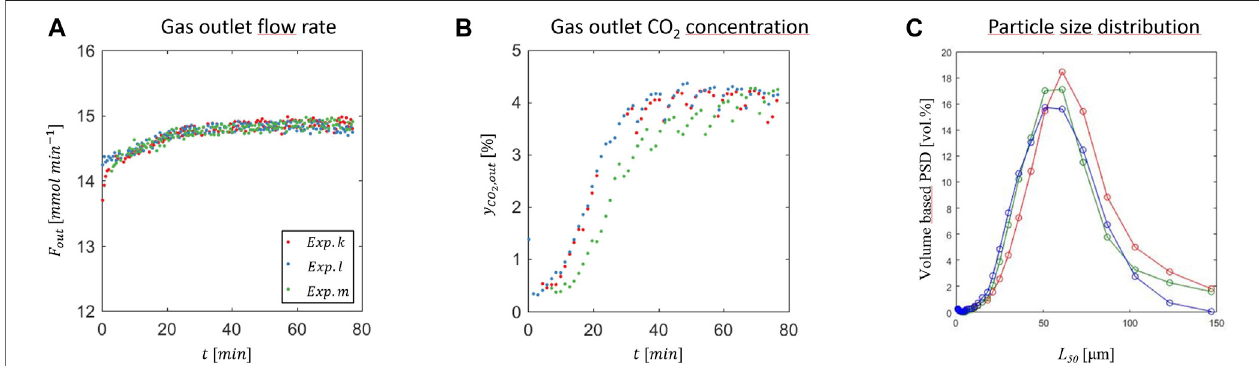
FIGURE 2 | Precipitation of CaCO 3 at 25 ° C, 25% CO 2 in N 2 , 1.25 bar, ψ F of 1.08 and a r min of 10.73 mmol/min/l: Three repetitions of (A) the outlet gas mass fl ow rate, (B) the